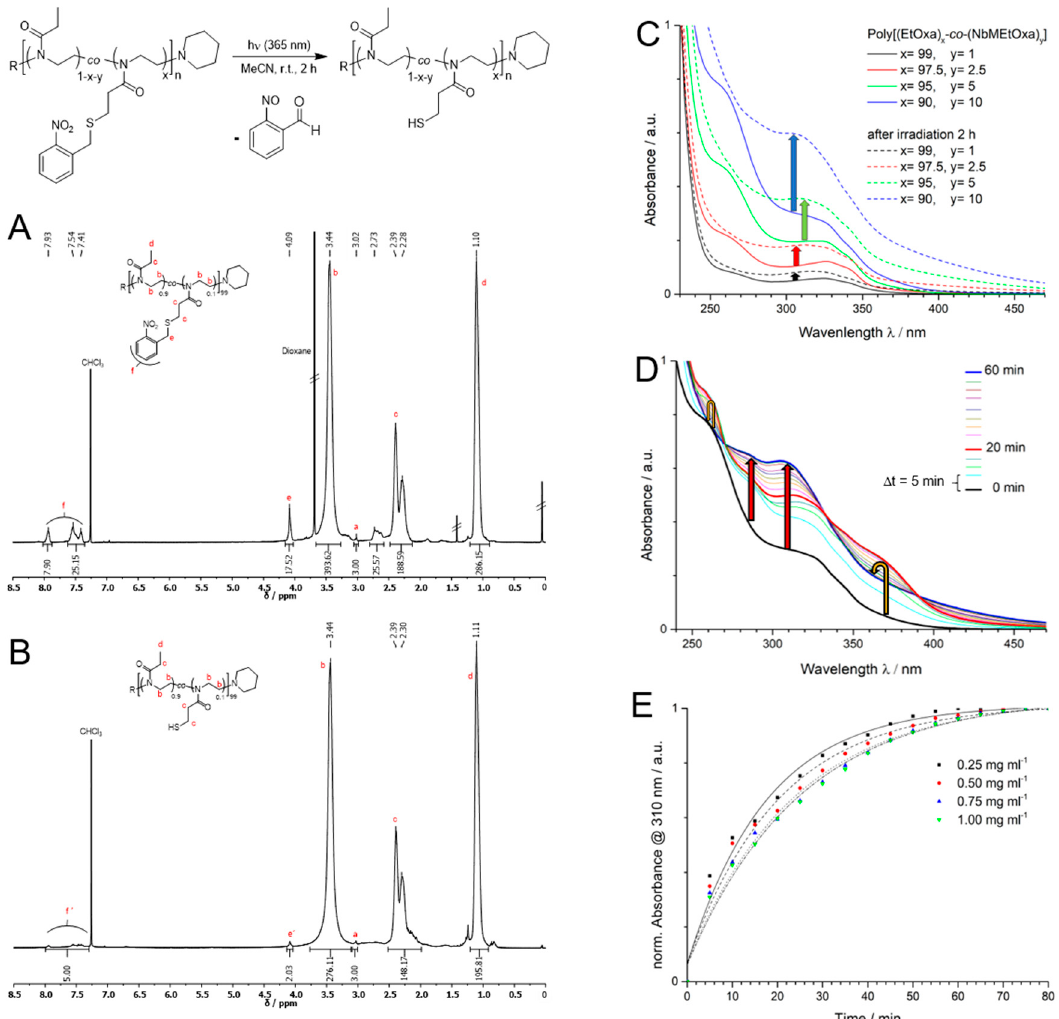
Figure 2. Deprotection reaction scheme for copolymer P10% and the corresponding 1 H NMR spectra recorded before ( A ) and after irradiation with UV light ( λ = 365 nm) ( B ). R = EtOxa-homoblock of initiator species, signals a and a’ correspond to the terminal methyl group of the initiator block R (the corresponding integrals are normalized to three protons), and signals e’ and f’ in ( B ) indicate residual PPGs after the deprotection step. These signals were used to calculate the degree of polymerization. In graph ( C ), UV/Vis spectra of polymers containing different amounts of protected thiol moieties in acetonitrile solution (c = 0.25 mg ml − 1 ) are depicted. Spectrum ( D ) shows the time-dependent absorbance change during deprotection of P10% . Deprotection kinetics ( E ) are shown for different polymer concentrations. The absorbance was measured at its maximum for o -nitrosobenzaldehyde at λ max = 310 nm. The dashed lines are drawn to guide the eye. The arrows indicate the change in absorbance with increasing time.